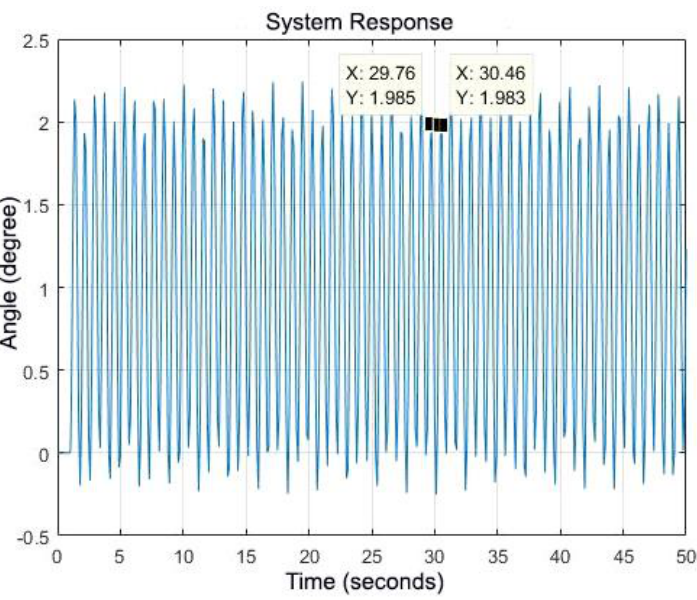
Figure 9. Test Results for 𝑲 𝒄𝒓